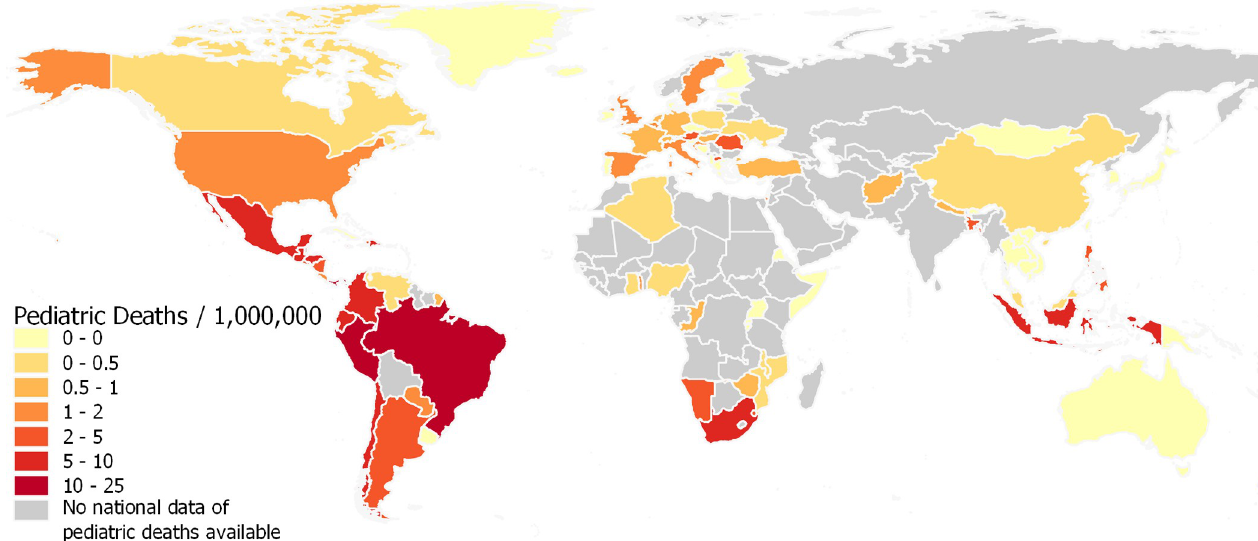
Fig 2. World map of national pediatric COVID-19 deaths (/1,000,000 children). The map was built with the geographic information system QGIS (v3.10, https://qgis.org) and the World Bank Official Boundaries Data Set (https://datacatalog.worldbank.org/dataset/world-bank-official-boundaries). Deaths are presented per million children. Countries of no pediatric case reported includes the country clearly report that there was no confirmed case in children in the national report as of December 7, 2020. National reports published more than 2 months before December 7 were included, if the countries were CDC COVID- 19 Level 1 (low transmission) since the date of